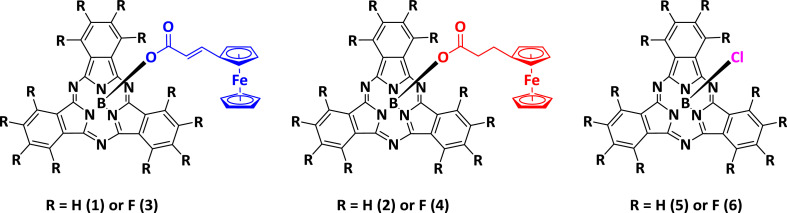
Structure of compounds in this study: (Fc(CH)2COO)-BSubPc(H)12, 1, (Fc(CH2)2COO)-BSubPc(H)12, 2, (Fc(CH)2COO)-BSubPc(F)12, 3, (Fc(CH2)2COO)-BSubPc(F)12, 4, Cl-BSubPc(H)12, 5, and Cl-BSubPc(F)12, 6.